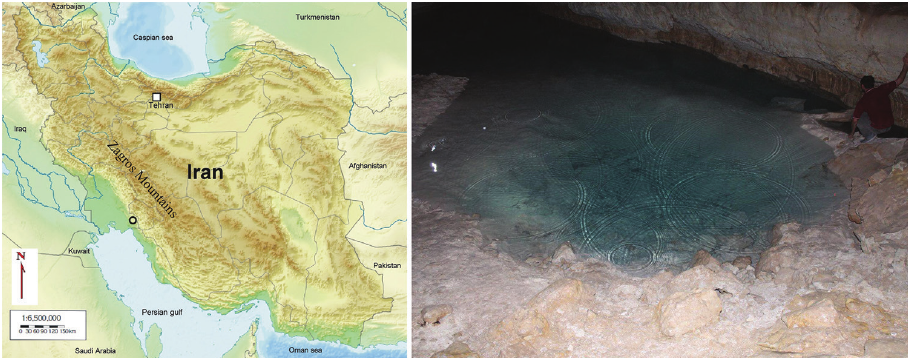
Figure 1. Left: Map of Iran, showing the location of Tashan Cave (black circle); Right: the type locality in Tashan Cave, with Stenasellus tashanensis sp.